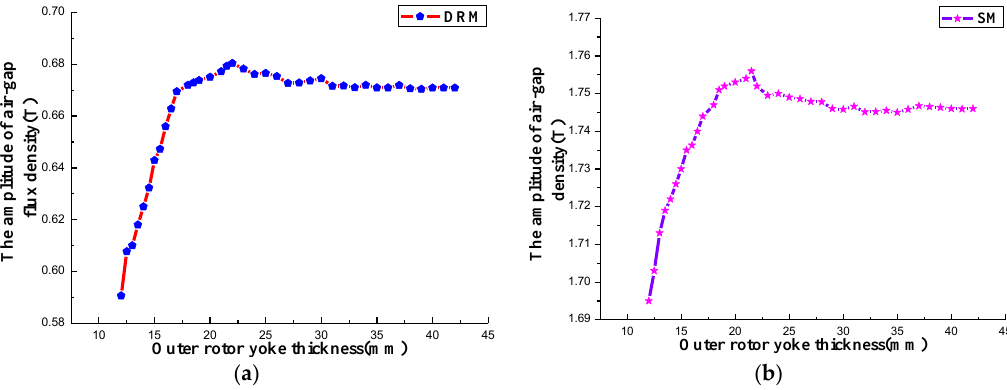
Figure 12. The air-gap flux density amplitude curves in the DRM and SM when the yoke thickness of the outer rotor is changing: ( a ) DRM; ( b ) SM.